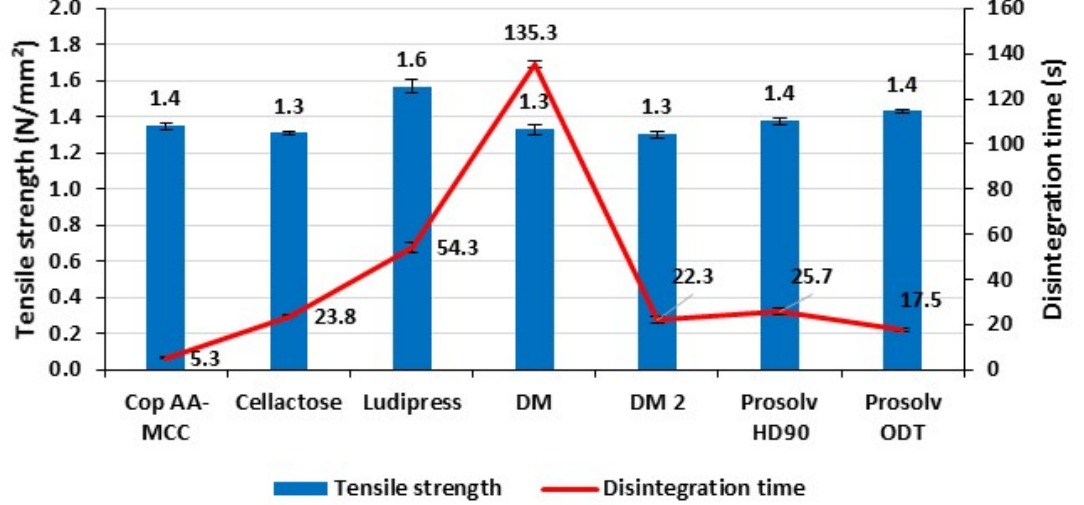
Figure 5. Disintegration time of the non-lubricated tested materials at a tensile strength confined between 1.3 and 1.6 N/mm 2 .